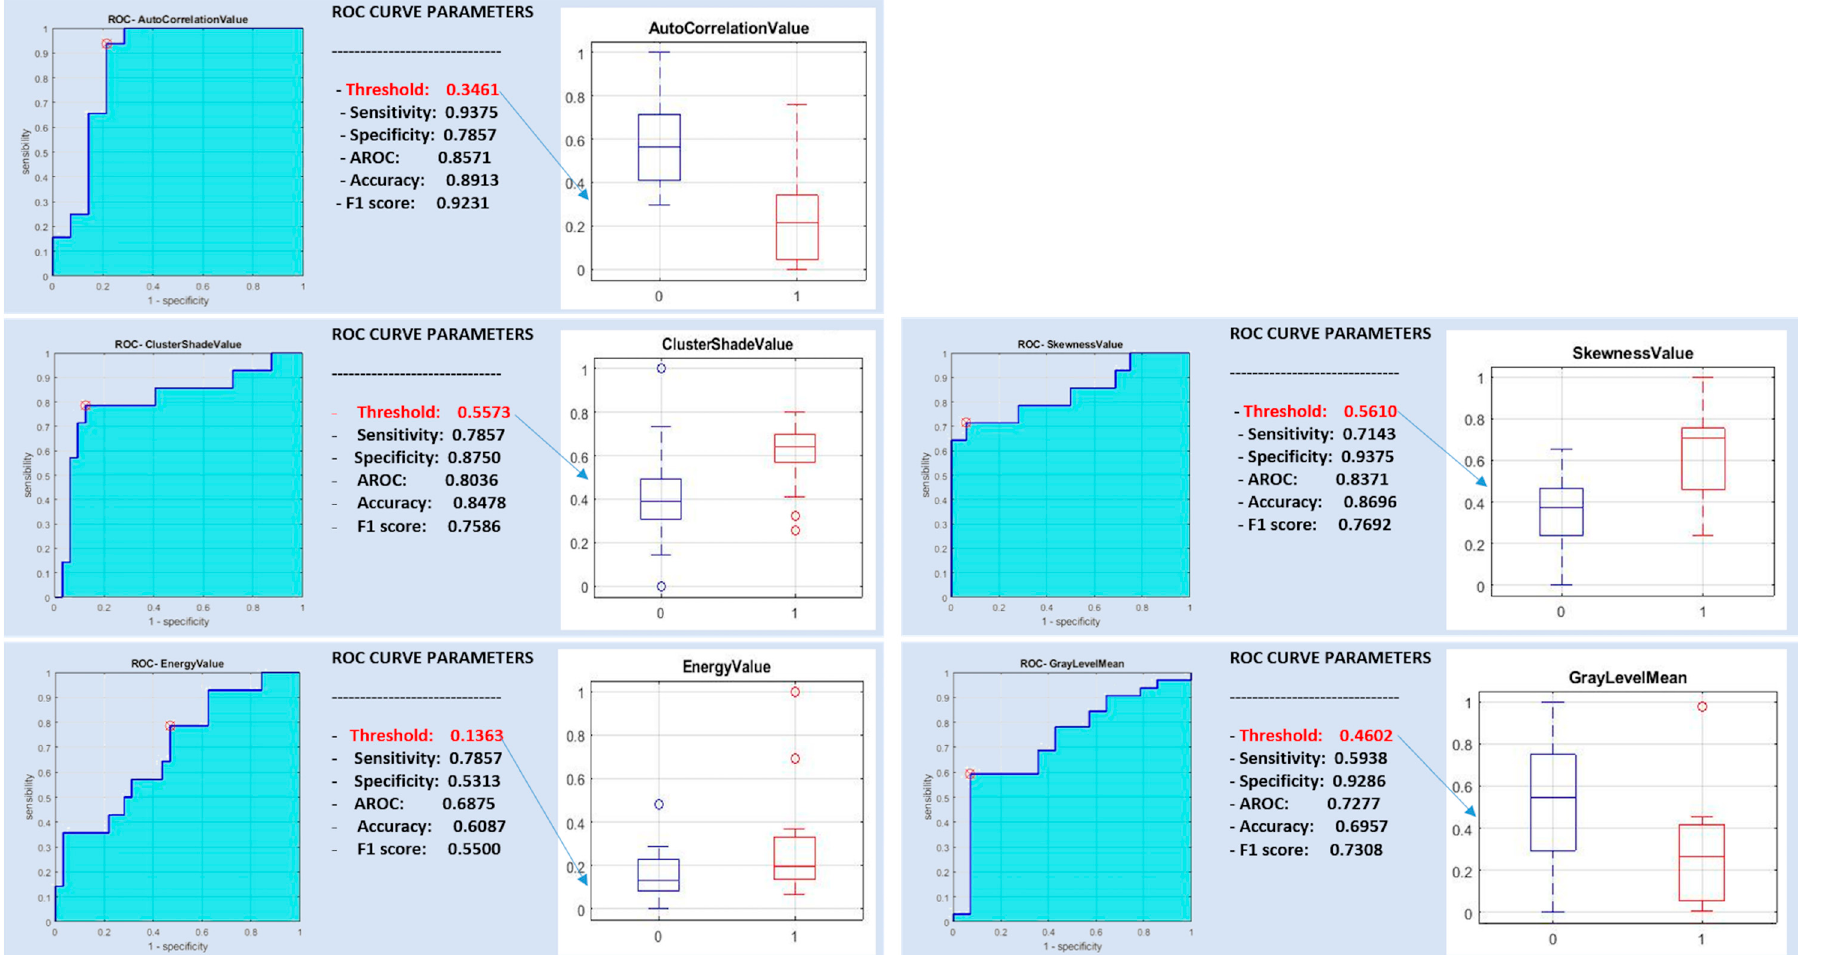
Figure 4. ROC curve analysis for pleomorphic adenoma versus malignant tumors.